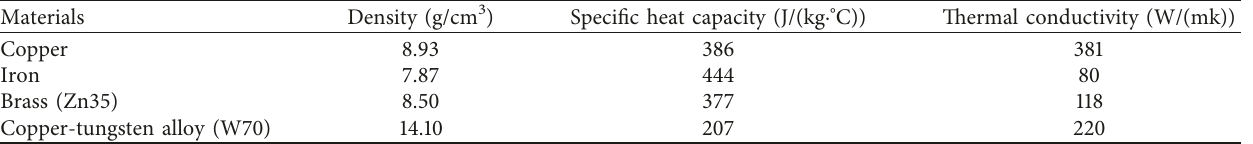
Table 2: Physical parameters of common metals [18].